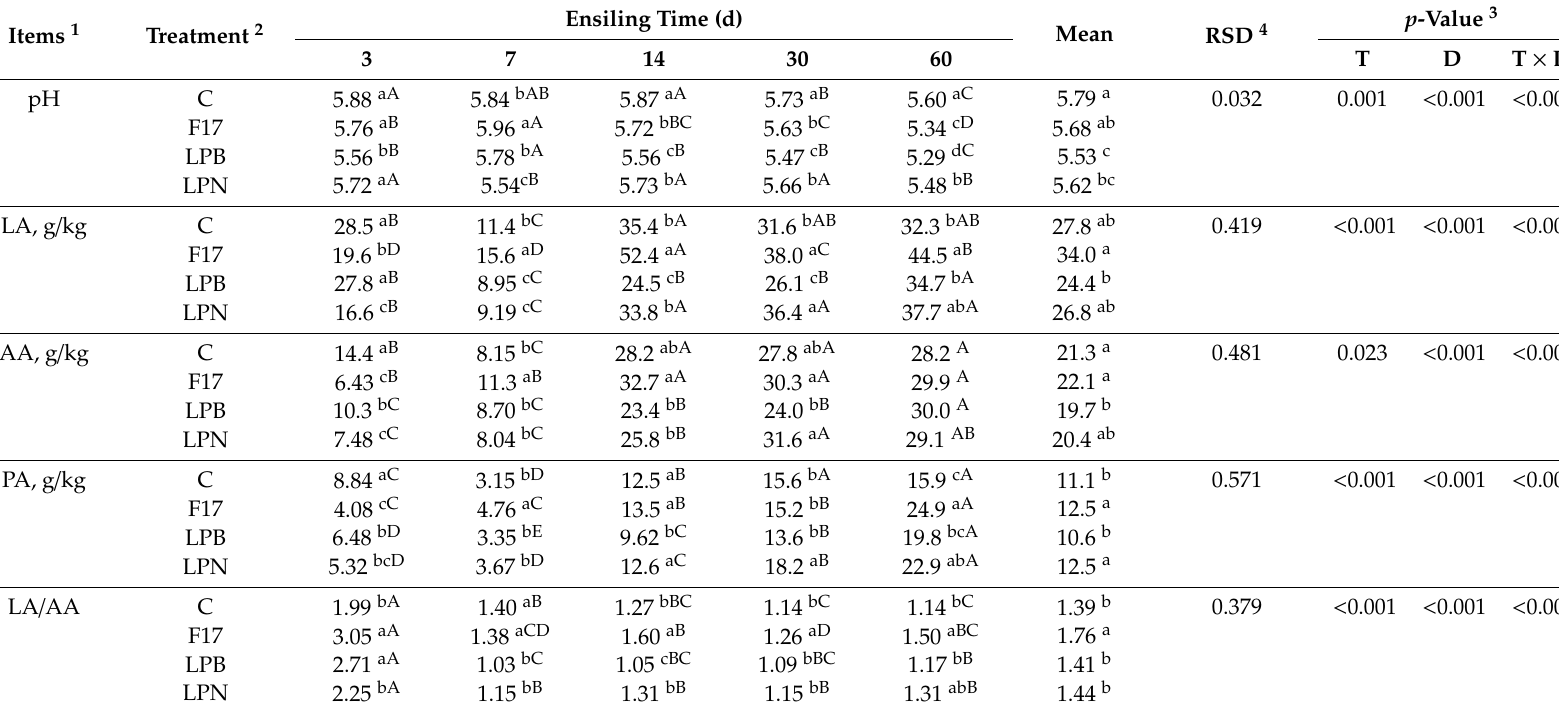
Table 1. E ff ects of additives and ensiling time on the fermentation characteristics (dry matter (DM) basis) of